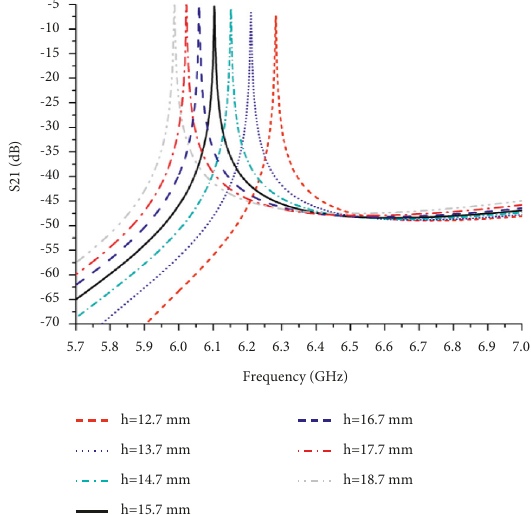
Figure 7: The predicated transmission coefficient of the proposed sensor with different values of